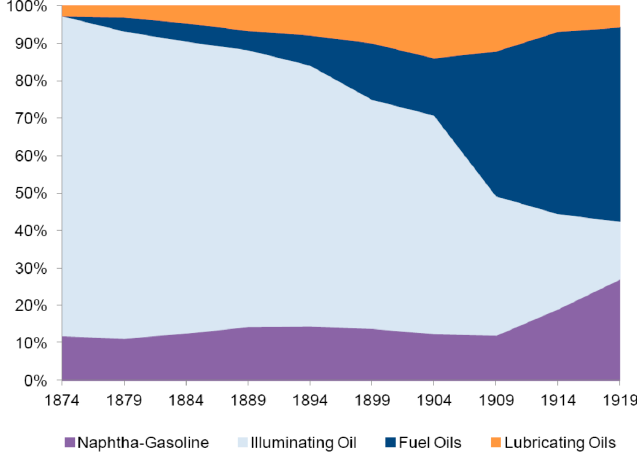
Figure 2. Shares of U.S. oil refinery output from 1874 to 1919